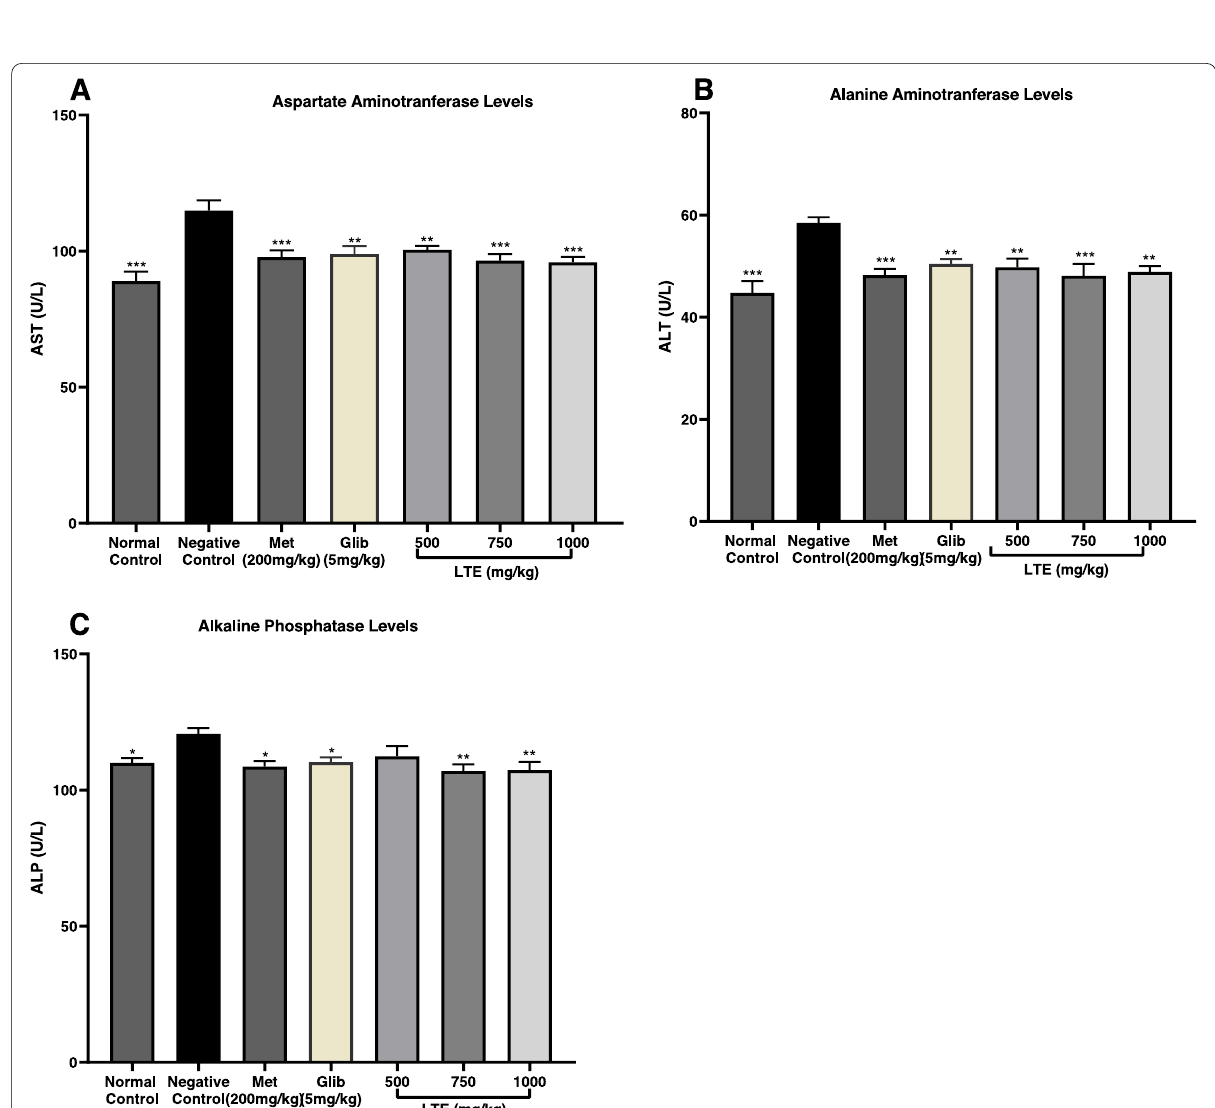
SEM ( n 5). Data were analyzed using one‑way ANOVA followed by ± =